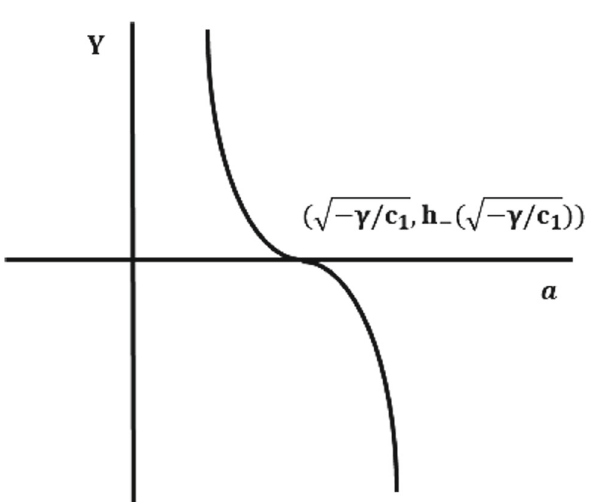
Fig. 1 Graph of h + ( a )